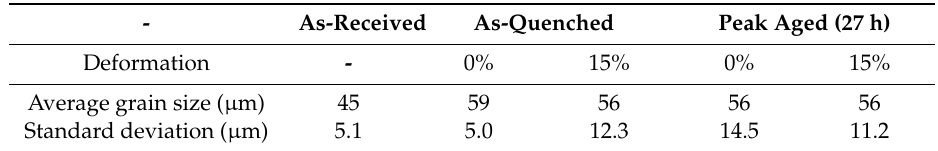
Figure 10. Optical micrographs of the alloy EN AW-7020. As-received state: ( a ) view along normal direction (ND), ( b ) view along transverse direction (TD). Solution heat treated, pre-deformed by 15% and peak aged for 27 h: ( c ) along ND, ( d ) along TD. Table 2. Average grain sizes of the alloy EN AW-7020 in different conditions measured with the linear intercept method.